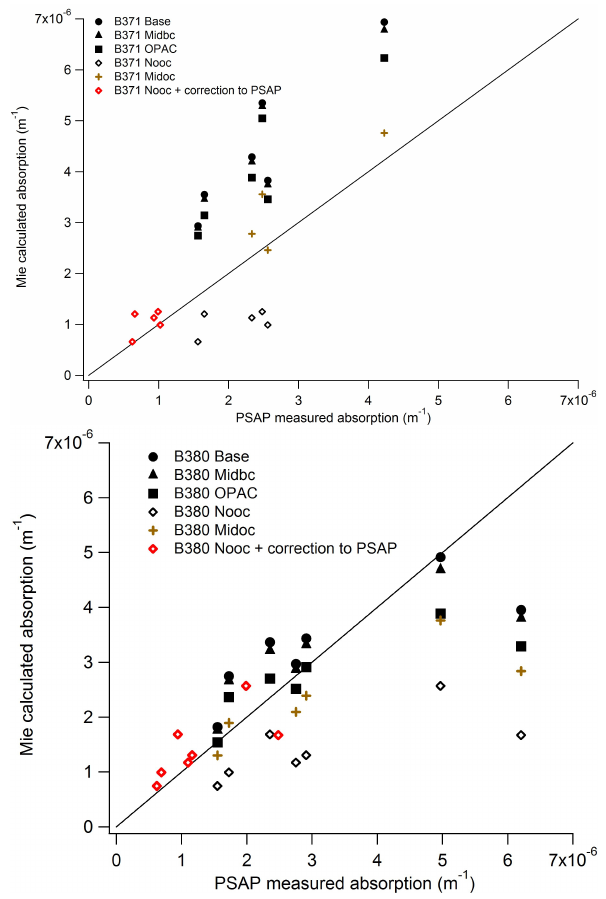
Fig. 9. Sensitivity of absorption closure to assumptions in refractive index of absorbing components for flights B371 (left-hand panel) and B380 (right-hand panel). “Base” is the control simulation as used elsewhere in the paper. “OPAC” refers to BC refractive in- dices from Hess et al. (1998), “Midbc” is the value from Stier et al. (2007). “Nooc” is a simulation with no absorption by organic carbon, whilst “Midoc” refers to an imaginary component for OC of 0.105 (half that in the Base case). The red diamonds represent the results of a “Nooc” simulation plotted against PSAP measurements that have been corrected assuming an overestimate of a factor 2.5 (based on methodology of Lack et al.,